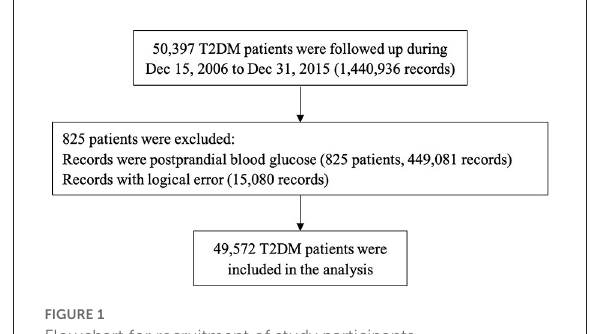
FIGURE1 Flowchart for recruitment of study